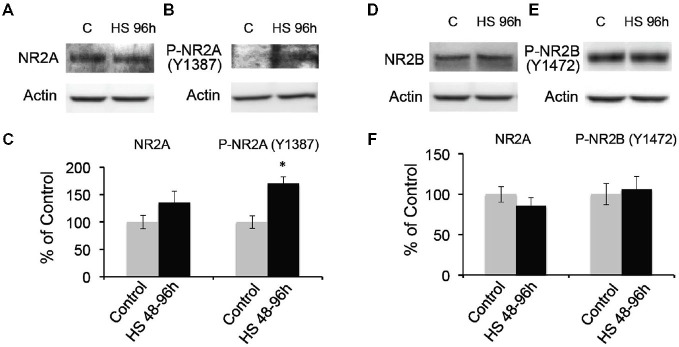
Hypoxic seizures-induced increases in GluN2A subunit phosphorylation at 48–96 h post-HS. (A–C) Western blot quantification of total and Phospho-GluN2A subunit (Y1387) in micro-disected hippocampus CA1 from control and 48–96 h post-HS rats (n = 20, 20). *p < 0.05. Error bars indicate S.E.M. (D–F) Western blot quantification of total and Phospho-GluN2B subunit (Y1472) in micro-dissected hippocampus CA1 from control and 48–96 h post-HS rats (n = 10, 10). Error bars indicate S.E.M.